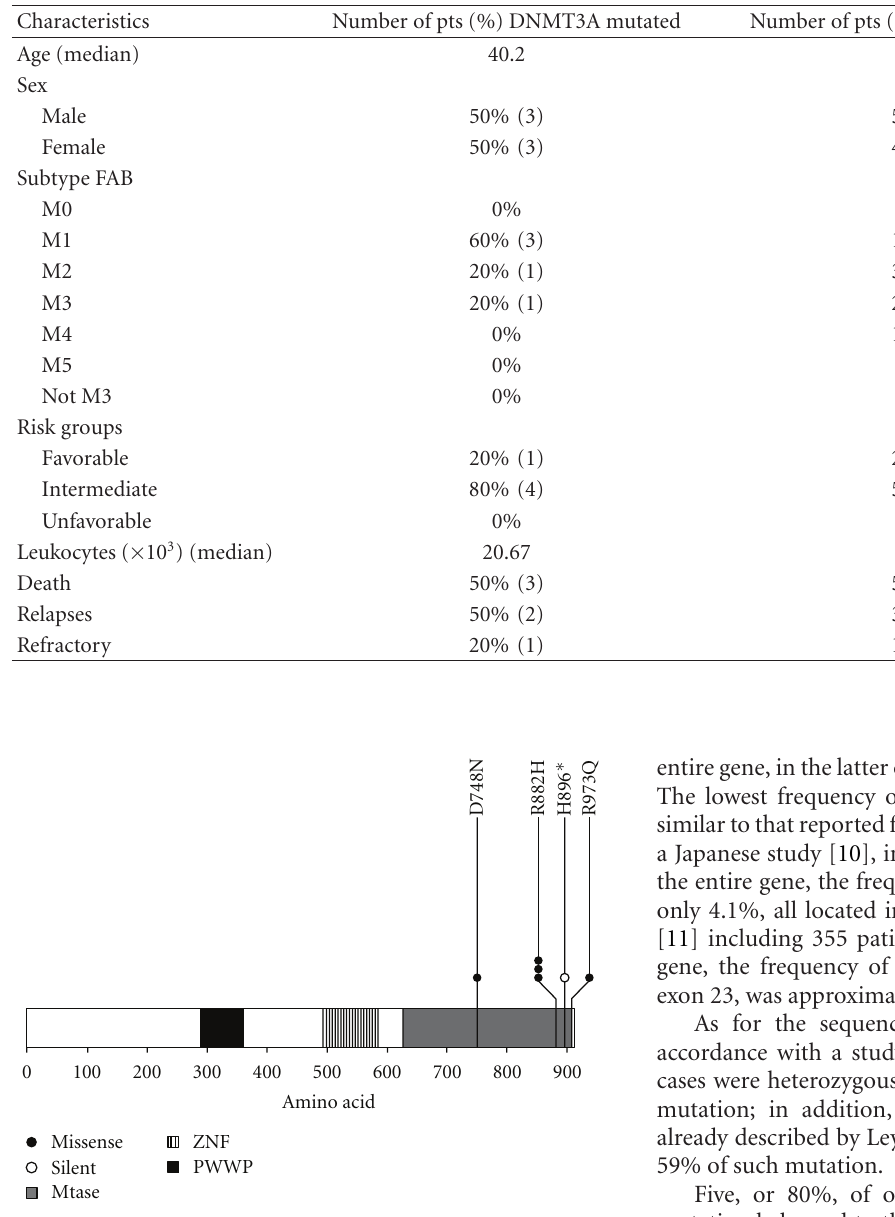
Table 5: Clinical characteristics of patients with acute myeloid leukemia with or without DNMT3A mutations.